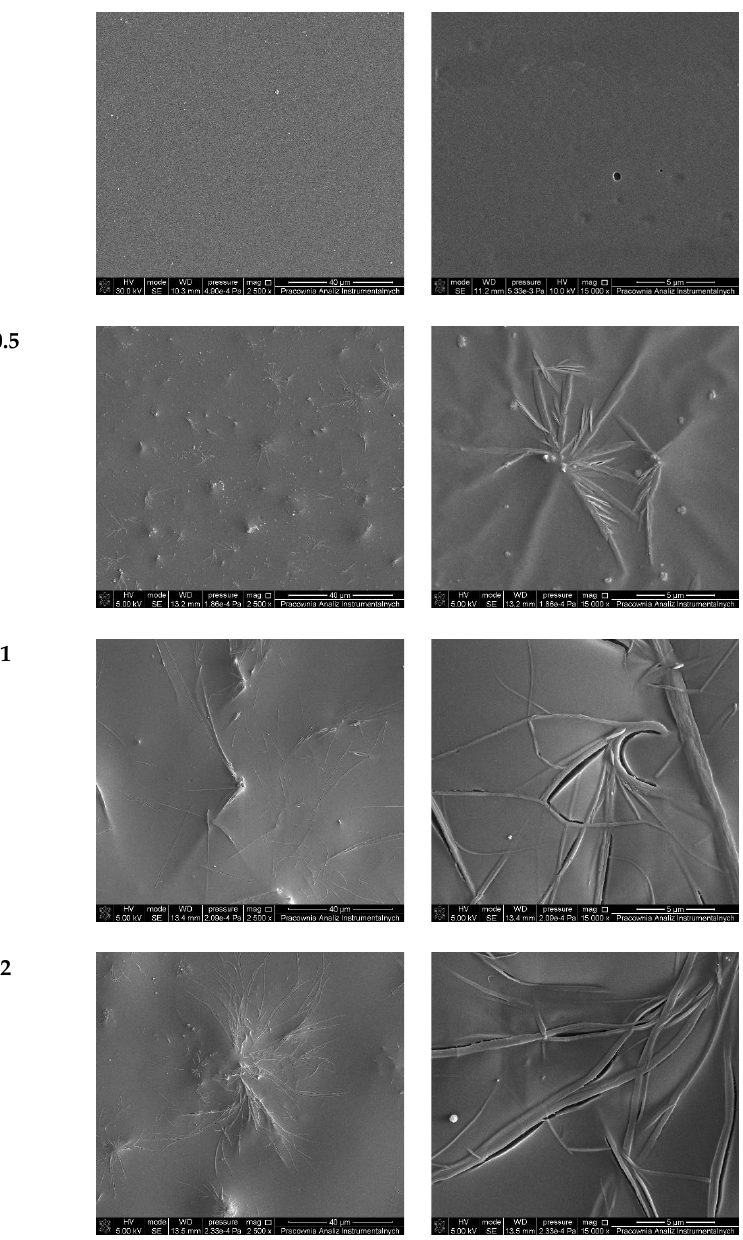
Figure 3. SEM images of studied materials. The incorporation of berberine into the LP system has a notable impact on the mor- phology of the obtained materials. Figure 3 depicts also the surface of the films comprising 0.5%wt., 1%wt. and 2%wt. of the biocidal agent respectively. In the case of all three of the above-mentioned samples, characteristic structures on the surface can be observed. Their presence indicates the crystallization process of berberine has taken place during the polymeric film-forming, and for this reason, the structures can be observed in the form of irregularly shaped filaments or needles embedded in the surface of the films. Moreover, the obtained results revealed that with the increasing amount of berberine in the polymeric ma- trix, the number and size of the scattered structures increases. This phenomenon indicates that the blends of the polymers and additives are immiscible